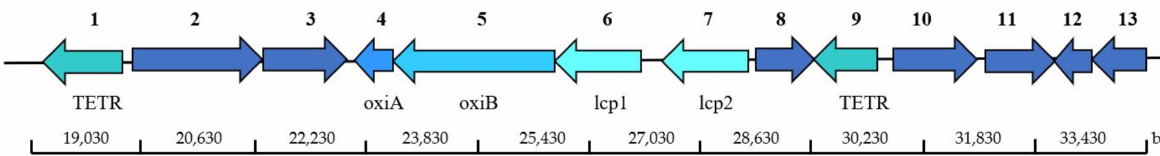
Figure 3. Location of lcp1 and lcp2 , and adjacent genes in Microtetraspora sp. AC03309 located on chromosome (contig 3): 1, Transcriptional regulator, TETR family; 2, Long chain fatty acid CoA ligase (EC 6.2.1.3); 3, Acetyl CoA dehydrogenase, short chain specific (EC 1.3.99.2); 4; Isoquinoline 1-oxidoreductase alpha subunit ( oxiA ); 5, Isoquinoline 1-oxidoreductase beta subunit ( oxiB ); 6, latex clearing protein 1 ( lcp1 ); 7, latex clearing protein 2 ( lcp2 ); 8, hypothetical protein; 9, Transcriptional regulator, TETR family; 10, MFS transporter; 11, hypothetical protein; 12, N-acetyltransferase; 13,